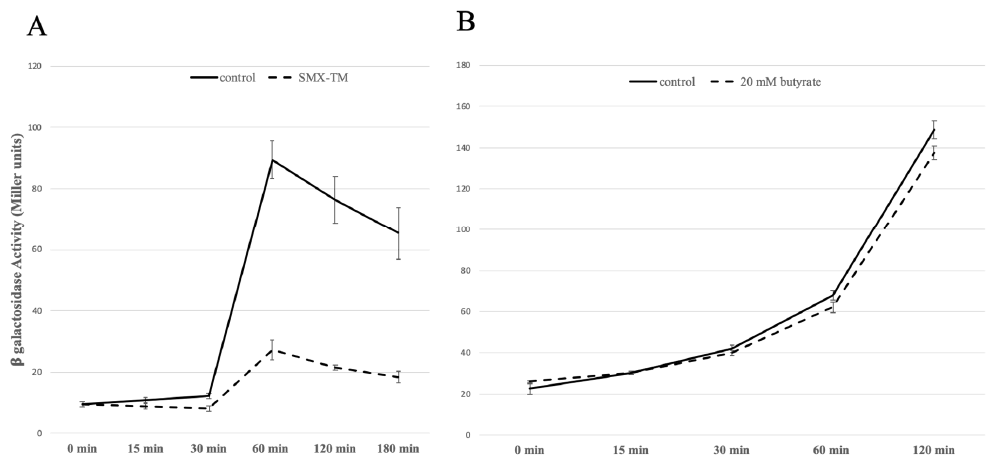
Figure 4. Comparisons of pchE promoter activities determined by β-galactosidase assays (Miller units). Growth of strain PA20Δ pchE pMLB1034:: pchE in Minimal Essential Medium (MEM) at 37 °C compared with growth in MEM containing either ( A ) 540/108 μg/L SMX-TM or ( B ) 20 mM sodium butyrate for the indicated times. Each timepoint represents the sample mean and SD of four independent cultures.